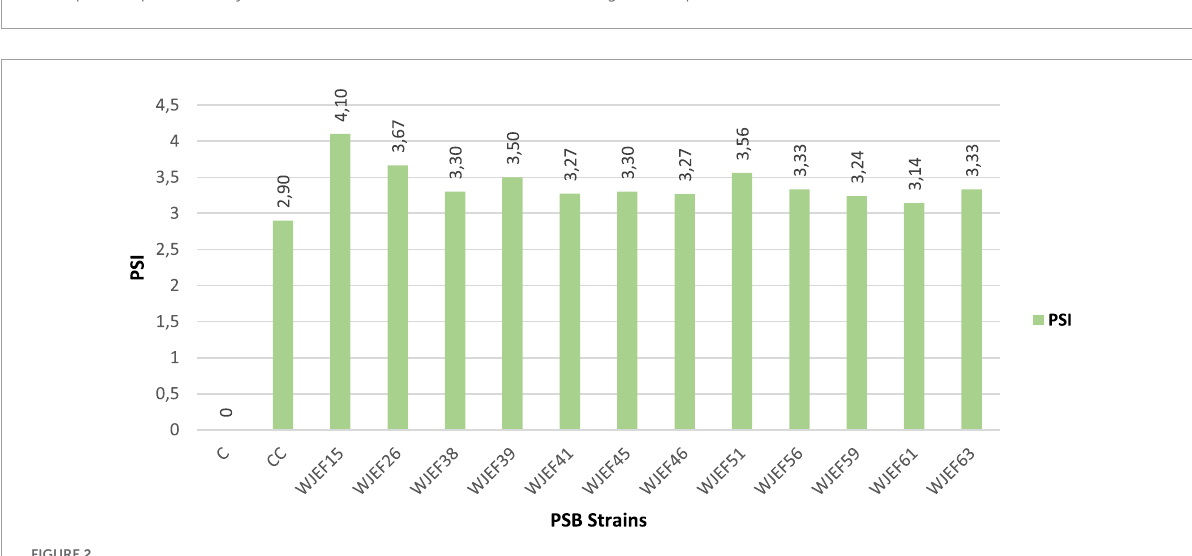
FIGURE1 Principal component analysis of different soil in the function of mineralogical composition.